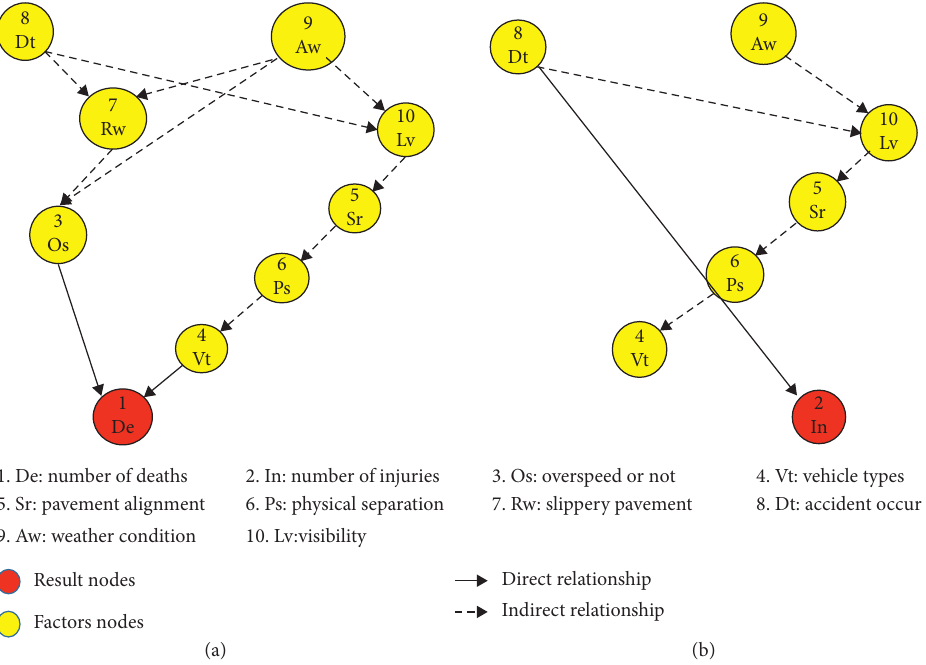
Figure 7: Final BN result of single-vehicle traffic accident, (a) factors contributing to the number of deaths and (b) factors contributing to the number of injuries.